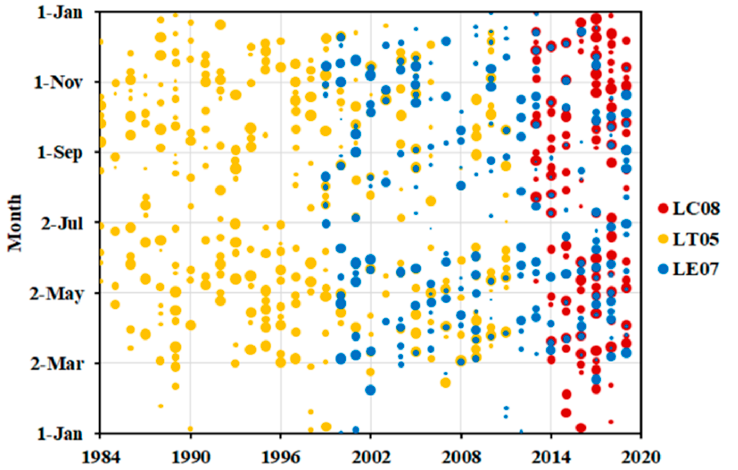
Figure 2. Scene acquisition dates for the Landsat images from 1985 to 2019. The size of the bubbles indicates useful observation areas which masked the “bad pixels” for the whole study area. The size of bubbles represents the valid data areas changed from 500 (the smallest size) to 13,000 km 2 (the largest size).